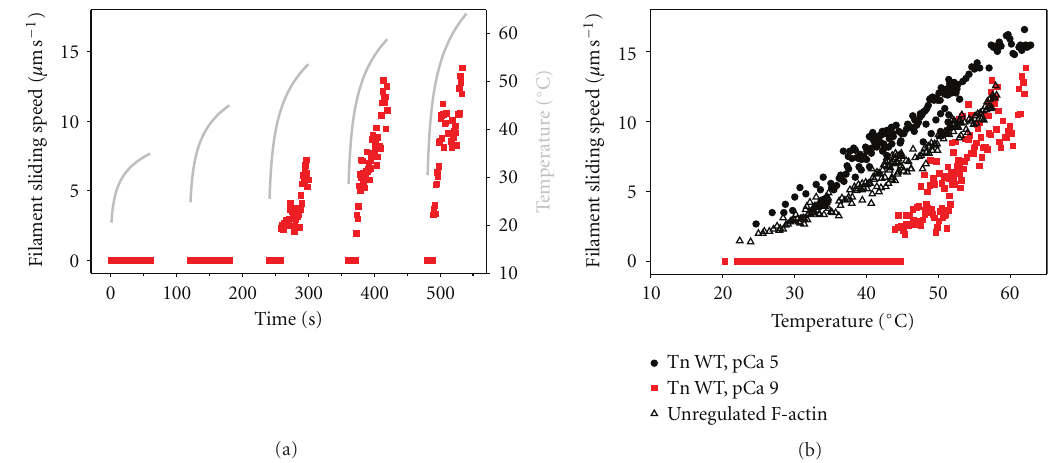
Figure 2: Thin filaments remain motile but lose Ca 2+ -regulation at high temperature. (a) Time course of temperature (gray line; right ordinate) and sliding speed (solid squares, red fill; left ordinate) for regulated thin filaments (F-actin plus rhcTn and α -Tm) at pCa 9 during the heating phase of five cycles of heating and cooling. Points represent the mean sliding speed for 3–5 filaments during 1s. At pCa 9, nonzero sliding speeds in heating cycles 3–5 indicate loss of Ca 2+ -regulation (dysregulation); note that temperature-dependent loss of Ca 2+ -regulation is fully reversible following cooling (beginning of cycles 4-5). (b) Data from (a) (pCa 9; solid squares, red fill) were replotted to eliminate time. Additional data for regulated thin filaments (F-actin plus rhcTn and α -Tm) at pCa 5 ( (cid:2) ) and unregulated F-actin ( (cid:5) ) from the same series of experiments are also shown for